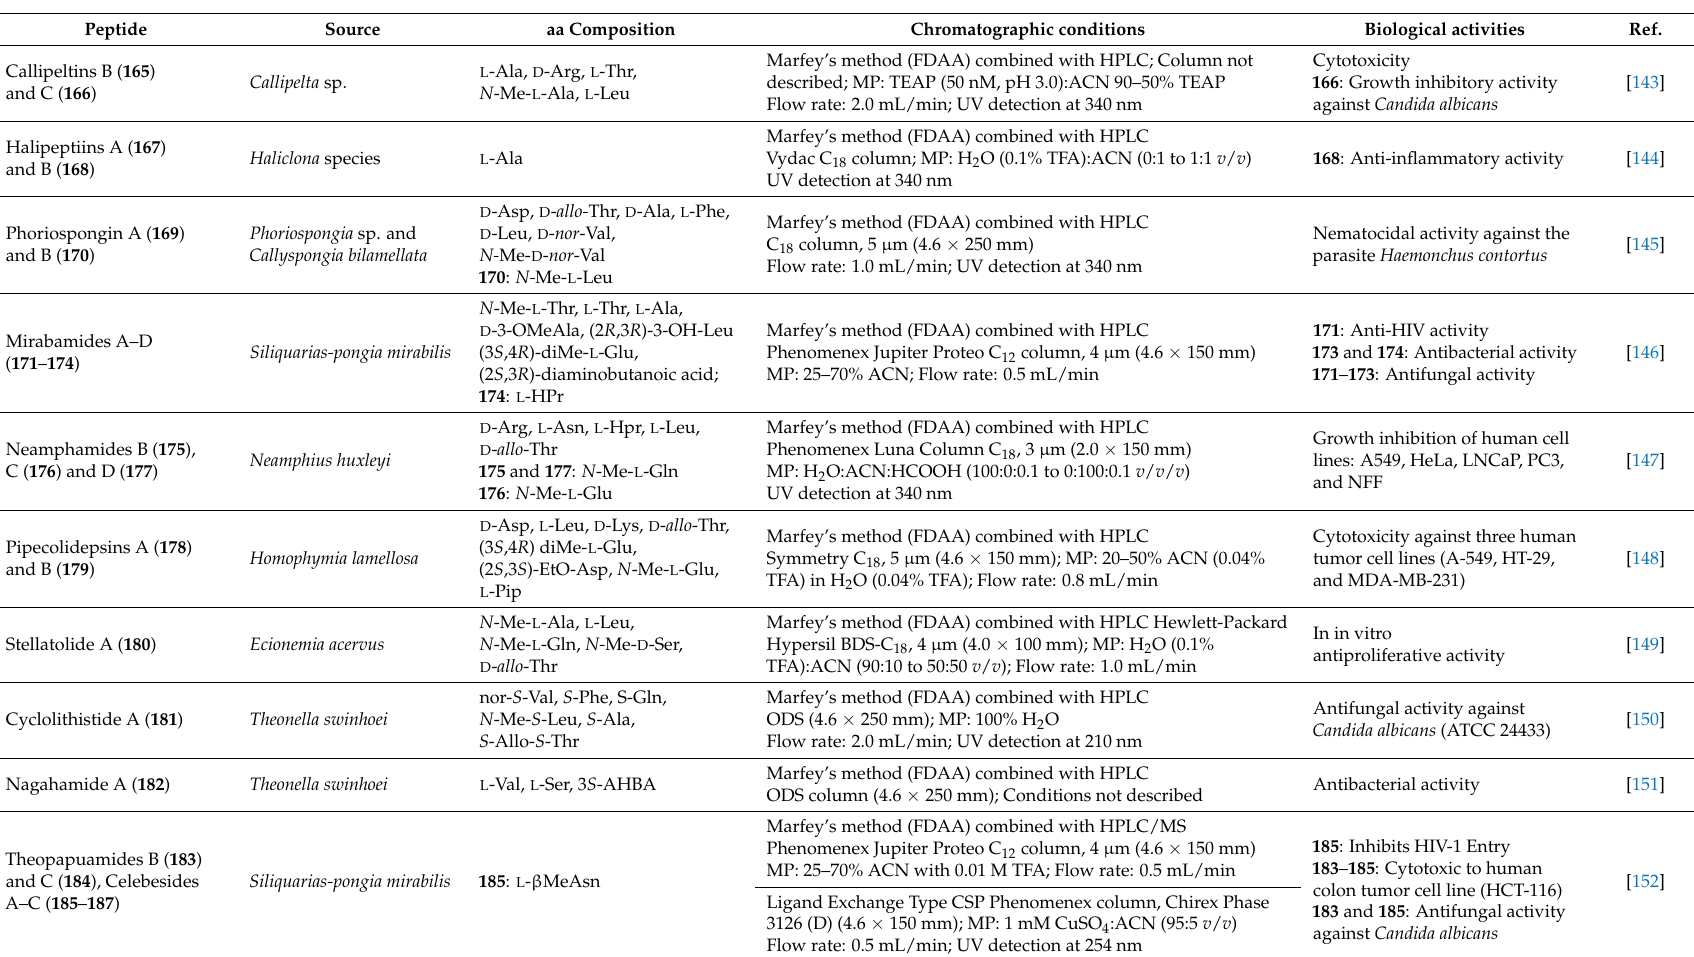
Table 7. Cyclic depsipeptides from marine